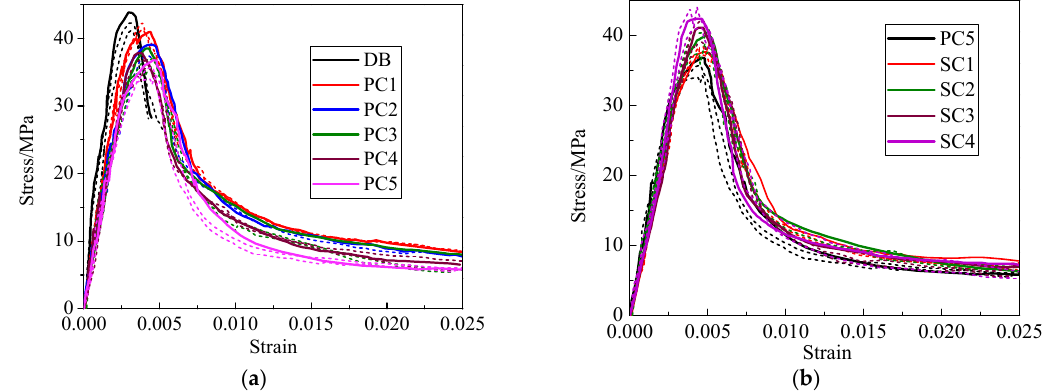
Figure 4. Strain-stress curves of specimen. ( a ) Specimens with PVA-PP Hybrid Fiber. ( b ) Specimens with PP-Steel Hybrid Fiber.